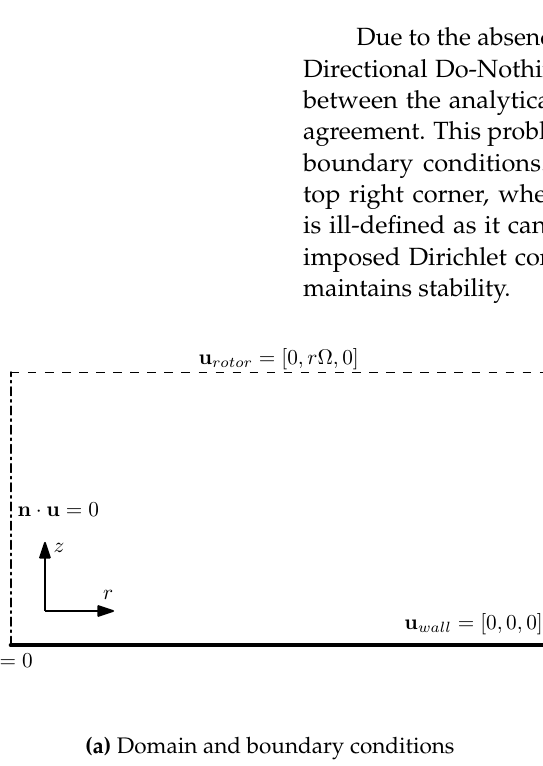
Figure 5. Enclosed rotor-stator problem benchmark and results. The domain has an aspect ratio of 0.5, which means that the radius is twice as high as the gap-length.